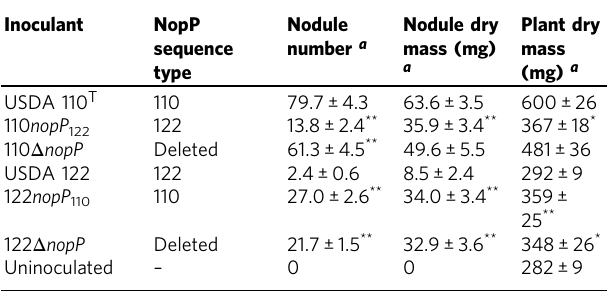
a Combineddatafromtwoindependentexperimentsareshown.Valuesaremean±SE( n = 11for USDA 110 T , n = 18 for USDA 122, and n = 12 for the others). Asterisks (*) indicate signi fi cant differences from the wild-type strain (USDA 110 T or USDA 122) by Dunnett ’ s multiple comparison test (* P <0.05, ** P <0.01)